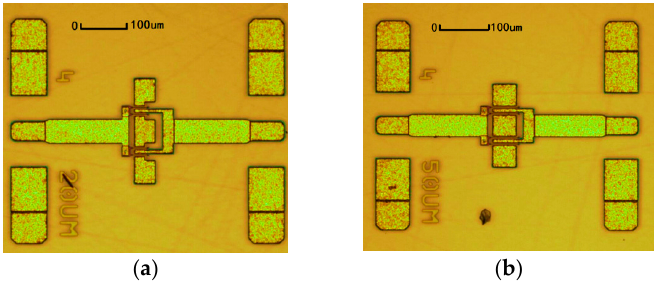
Figure 7. 0.1 µm AlGaN/GaN HEMTs: ( a ) 4 × 20 µm and ( b ) 4 × 50 µm.